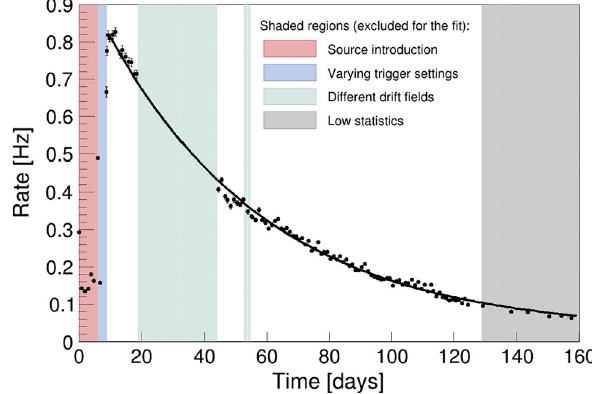
Fig. 13 Activity evolution of the selected 2 . 82keV data of 37 Ar over more than 4 half-lives with a one-day binning starting from the time at which the first ampule was broken. The fit was performed on 968V/cm dataonly,becauseatotherdriftfieldsthedatafeaturessystematicdevia- tionscausedbythevaryingefficiencyoftheapplieddata-drivencutsand corrections. The errors on the individual data points are Poisson-like. We obtain a half-life of ( 35 . 7 ± 0 . 4 )